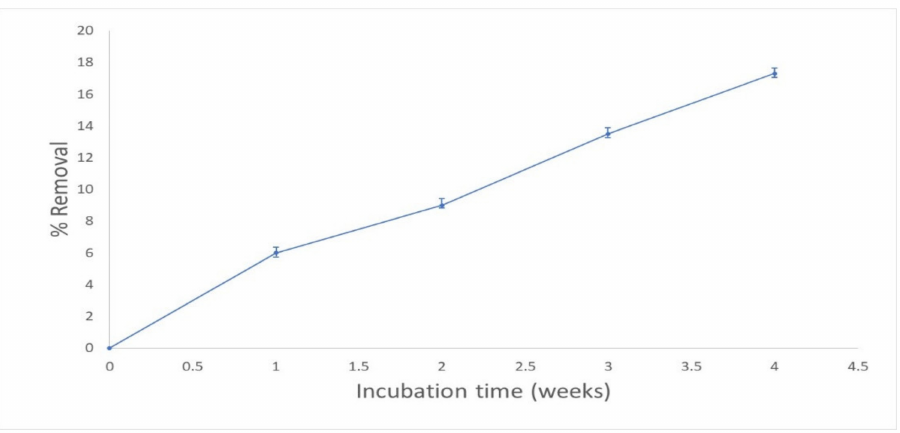
Figure 7. In vivo removal of 100 mg/L cobalt (II) (adjusted) from water contaminated (250 mL) by E. crassipes live. pH 6.8. 28 ◦ C. Static